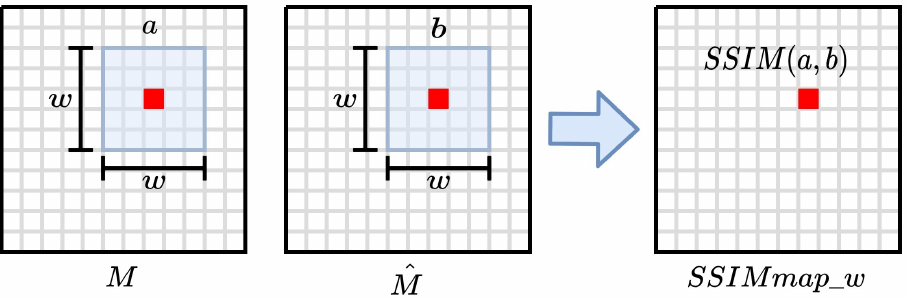
Figure 5. Demonstration of the SSIM map generation between images M and P . SSIM ( a , b ) represents the SSIM value between the local windows a and b .